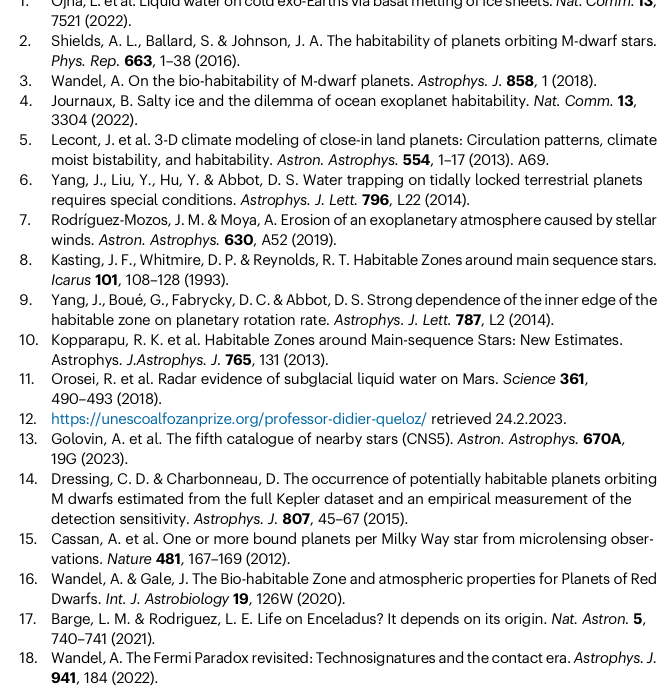
Fig. 2 | Thenumberofexpectedhabitableplanetsasa functionofthedistance fromEarthforvariousstartypes(lowercurve):onlysunlike(G-type)hoststars, second lowest curve: G+K type stars, third curve: G, K, and M type, all assuming 0.2 habitable planets per star. The upper curve is for M-dwarfs assuming one habitable planet per